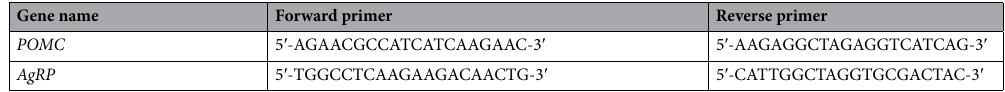
Table 1. Primers used for quantitative real time reverse transcription-polymerase chain reaction (RT-qPCR) of genes implicated in regulation of energy homeostasis in the hypothalamus.